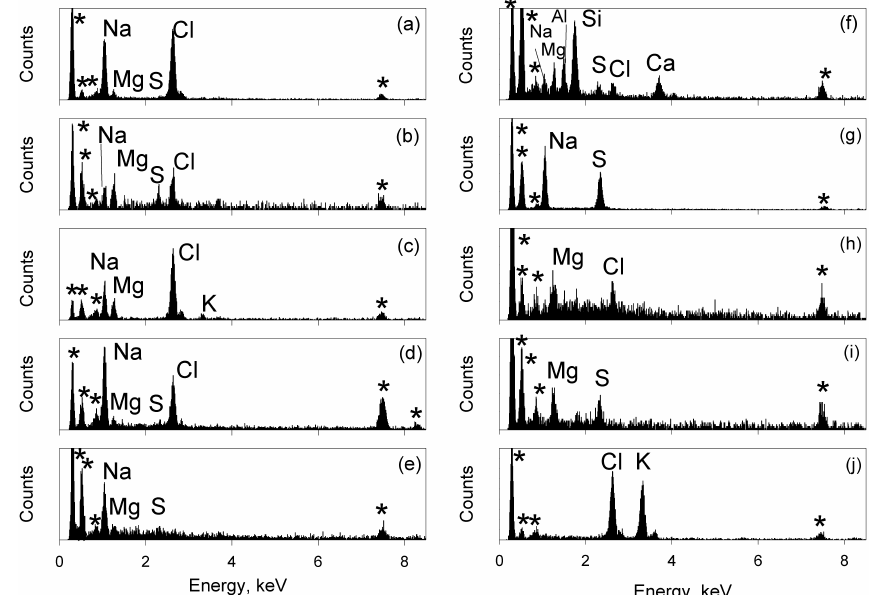
Figure 8. EDX spectra of sea-salt and sea-salt-related particles collected over the sea-ice area. Aerosol particles were collected (a) in coarse mode on 23 February 2014, (b) in fine mode on 20 February 2014, (c) in coarse mode on 21 February 2014, (d) in fine mode on 15 January February 2014, (e) in fine mode on 26 February 2014, (f) in coarse mode on 23 February 2014, (g) in coarse mode on 3 March 2014, (h) in fine mode on 19 December 2013, (i) in fine mode on 15 January 2014, and (j) in coarse mode on 19 January 2014. Asterisks denote background peaks derived from the sample substrate.